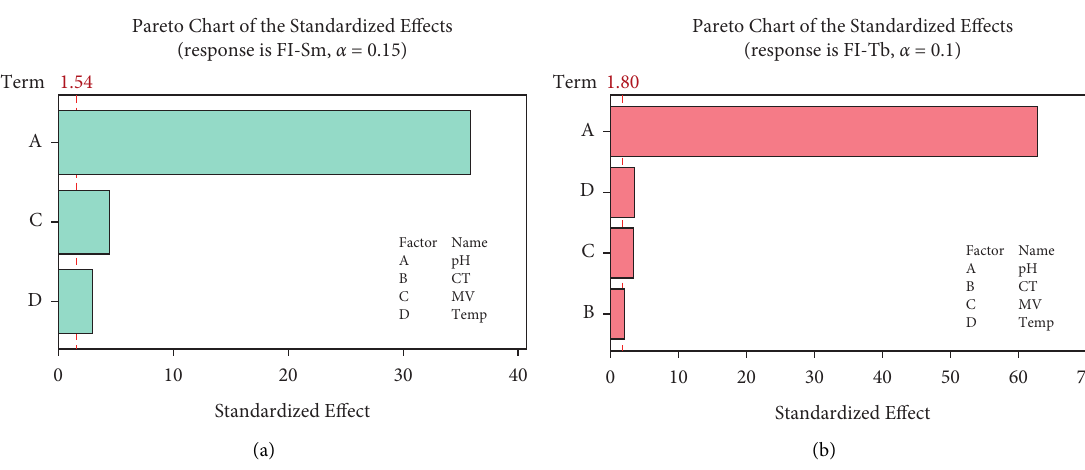
Figure 3: Pareto charts of the standardized effects for (a) ORLX-Sm(III) and (b) ORLX-Tb(III)